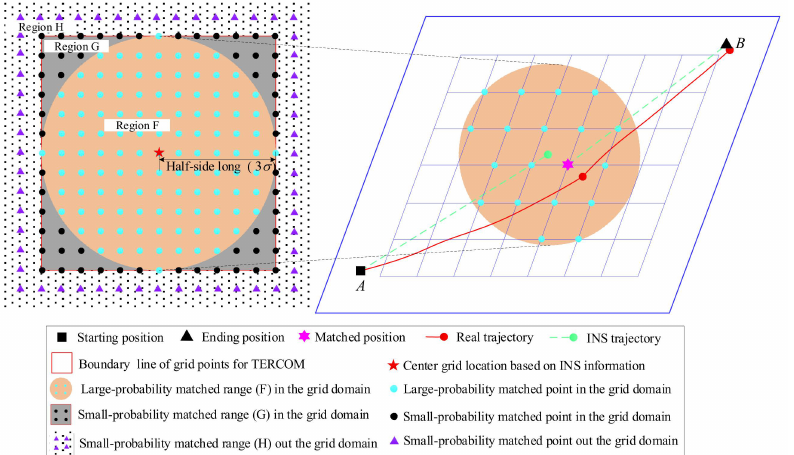
Figure 1. Matching-region classification of the surrounding area of TERCOM’s square